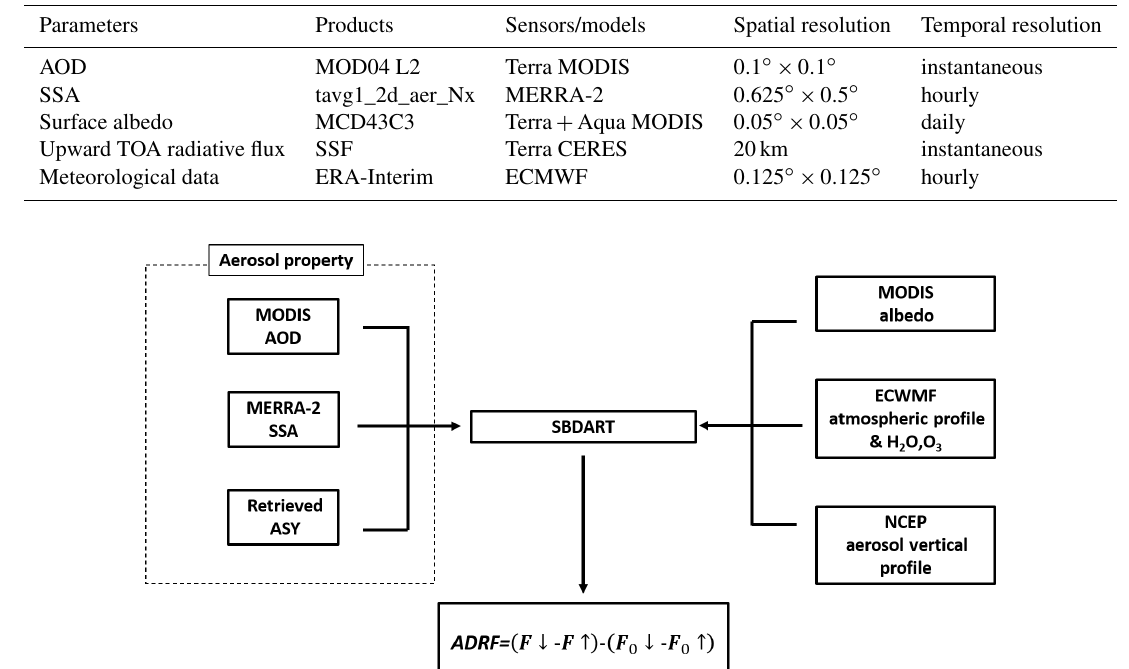
Table 1. Satellite and reanalysis datasets used in the study.